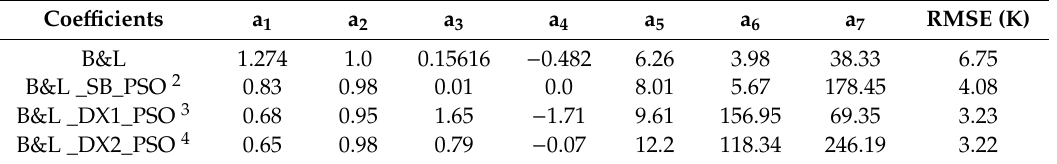
Table 3. Calculation coe ffi cients for the B&L algorithm in this